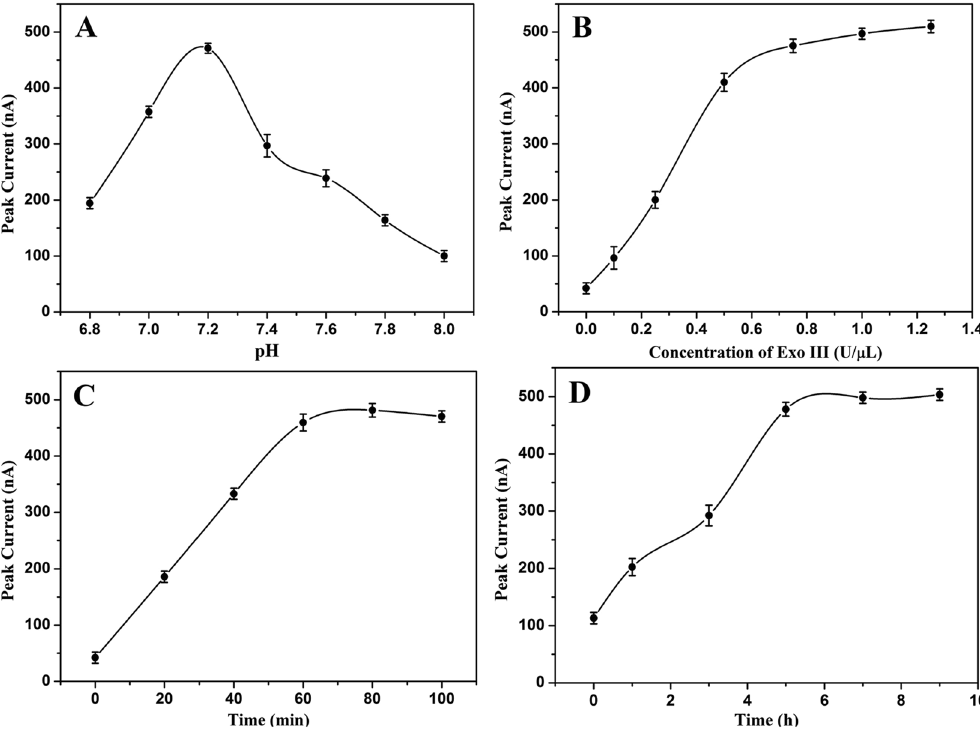
Figure 3. DPV peak current observed under ( A ) different pH values: 6.8, 7.0, 7.2, 7.4, 7.6, 7.8, and 8.0; ( B ) different Exo III concentrations: 0, 0.1, 0.25, 0.5, 0.75, 1, and 1.25 U/ μ L; ( C ) different reaction time of Exo III: 0, 20, 40, 60, 80, and 100 min; ( D ) different reaction time of melamine: 0, 1, 3, 5, 7, and 9 h. The concentration of melamine was 50 μ M. The error bars represent the standard deviation of three measurements.